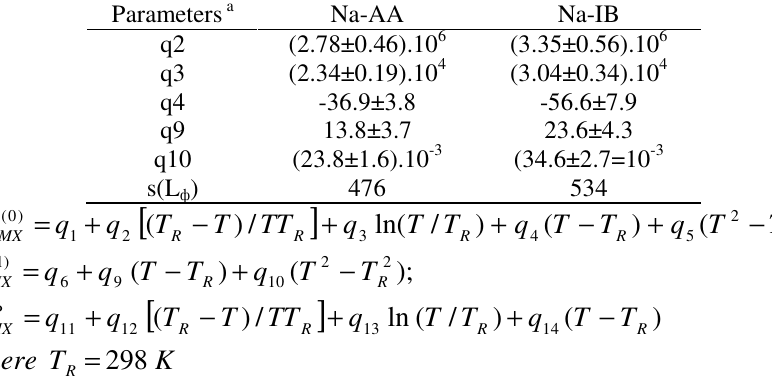
Table 2. Temperature independent parameters, q and